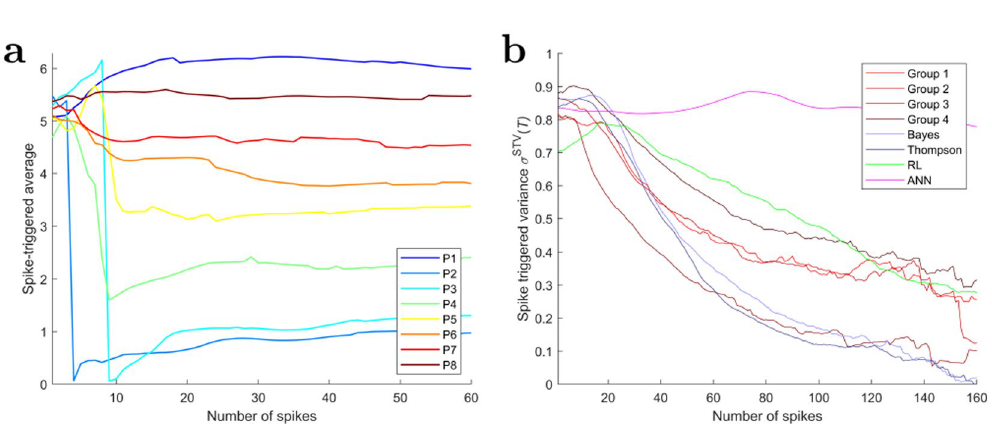
Figure 7. Changes in spike triggered average across time. ( a ) Temporal evolution of the mean target difference vector angle preceding a group response for each decision-maker in group 3. ( b ) Time dependency of the average spike triggered variance. The abscissa displays the ordinal spike number for each player. The estimate becomes more variable for large number of spikes due to the fact that most batches are terminated before reaching 100 spikes for many